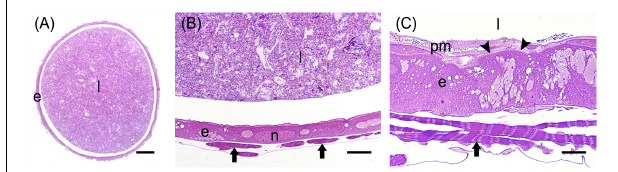
FIGURE 6 | Morphological organization of MMG2. (A) Cross-section of MMG2. (B,C) Details of the large flat cells that forms the thin epithelium in this midgut region. The short brush border (arrowheads) is visible in (C) . e: epithelium; l: lumen; arrows: muscle cells; n: nucleus; pm: peritrophic matrix. Bars: 200 µ m (A) , 20 µ m (B) , 10 µ m (C)